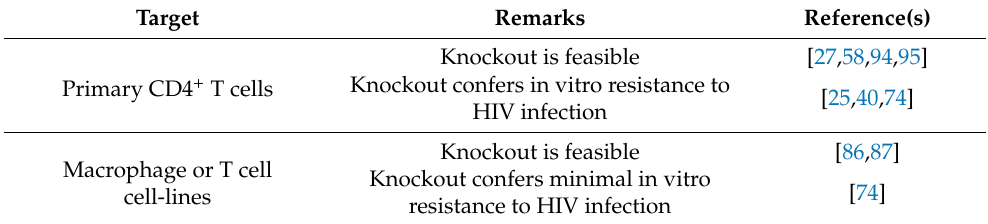
Table 3. CRISPR-mediated gene editing of